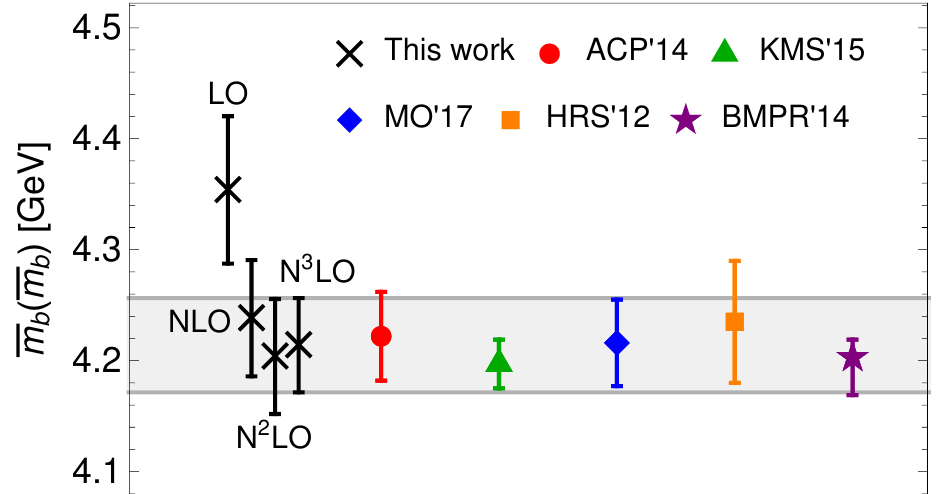
Figure 5 . Comparison of our result for the bottom-quark MS mass from M recent results from the masses of b (cid:22) b bound states (ACP’14 [9, 10], KMS’15 [11], MO’17 [12]) and non-relativistic sum rules (HRS’12 [8], BMPR’14 [5, 6]). The bottom-quark masses obtained from lower orders in pure perturbation theory, while retaining all known condensate contributions, are shown as well. The order of the PS-MS mass relation has been correlated with the order in perturbation